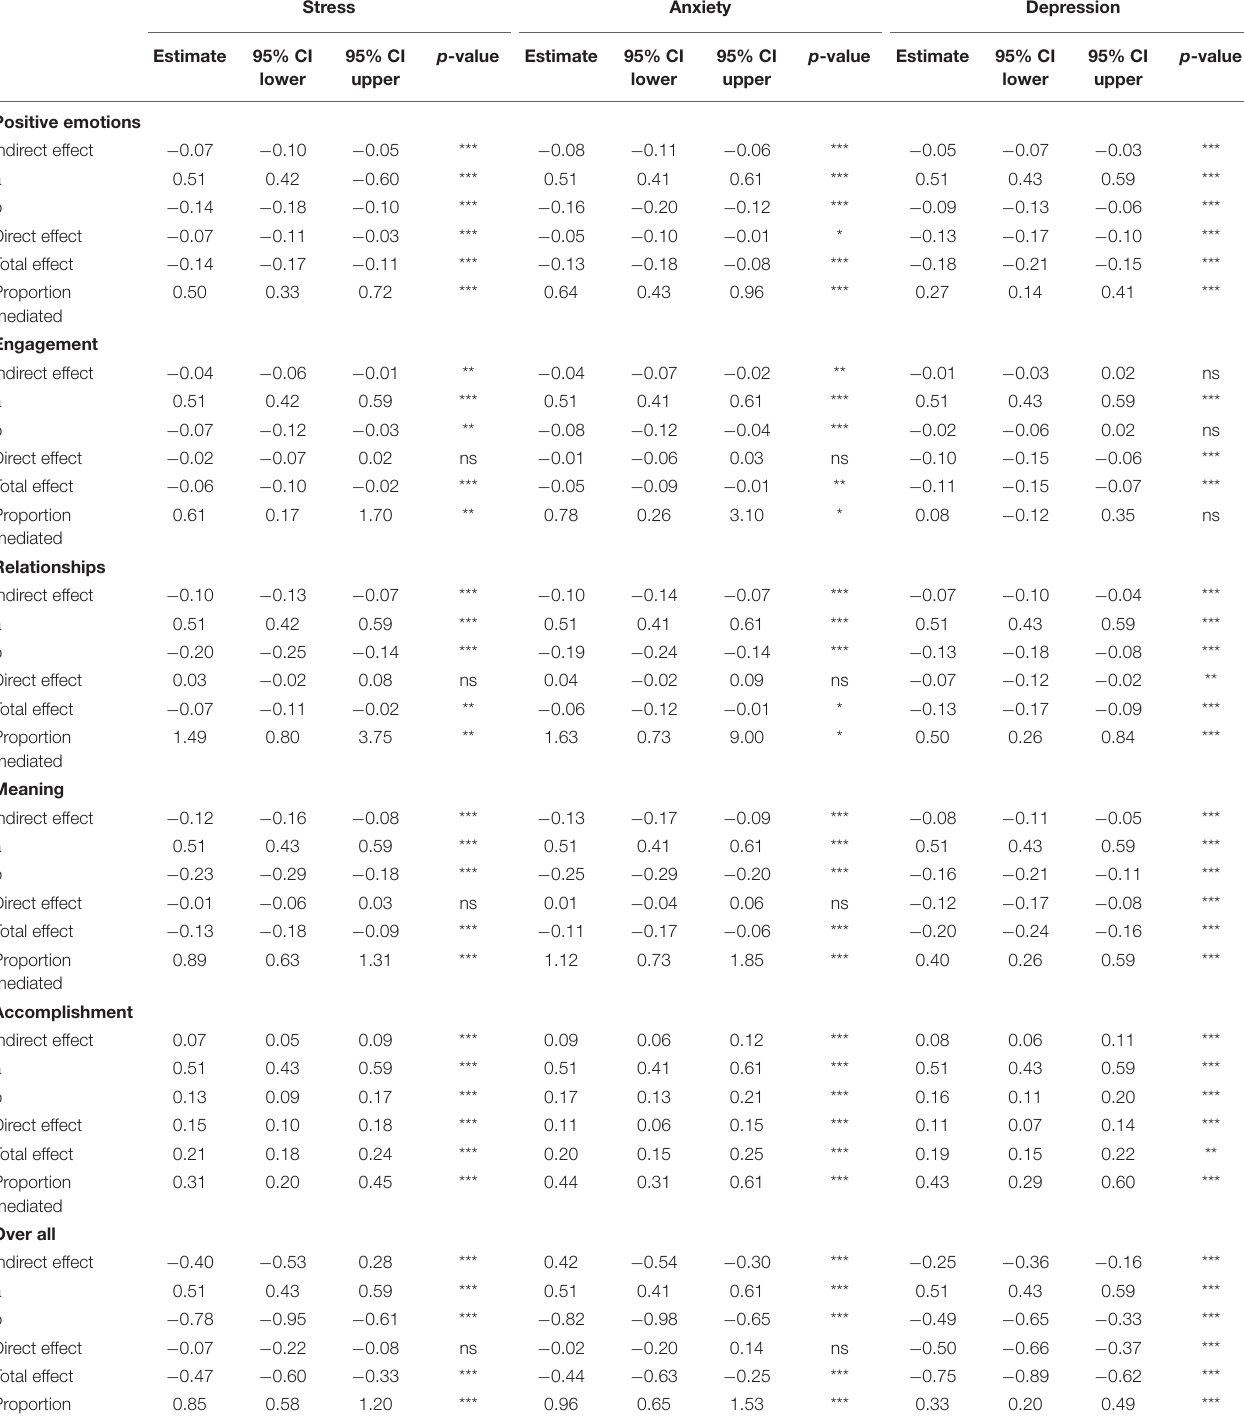
TABLE 4 | The mediating effects of psychological flexibility on the relationship between the DASS-21 and PERMA profiler scales. Stress Anxiety